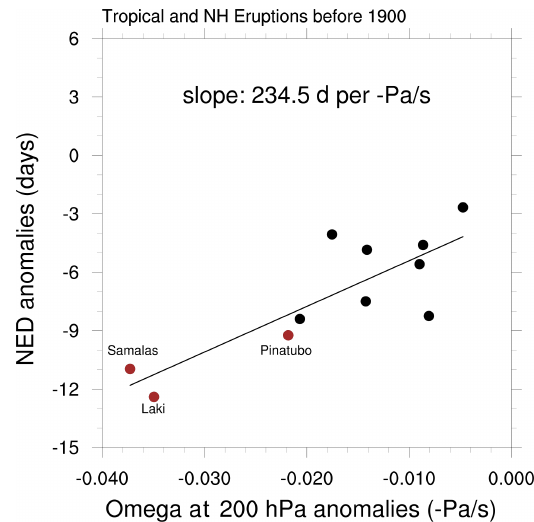
Figure 7. Scatter plot of the JA omega velocity anomalies ( − Pas − 1 ) at 200hPa averaged over the mean ascending region (black boxes in Fig. 6) against the corresponding NED anoma- lies in the CESM-LME. Selected summers correspond to the maxi- mum NED reduction according to Fig. S1. Negative omega velocity anomalies indicate reduced upwelling. Tropical and NH volcanoes before 1900 are used only. Brown circles denote Pinatubo, Samalas and Laki. A linear regression calculates a positive slope of about 2.3d per 0.01 − Pas − 1 significant at p < 0 . 01 based on a two-tailed t test. The negative sign in the unit of omega velocity denotes an up- ward